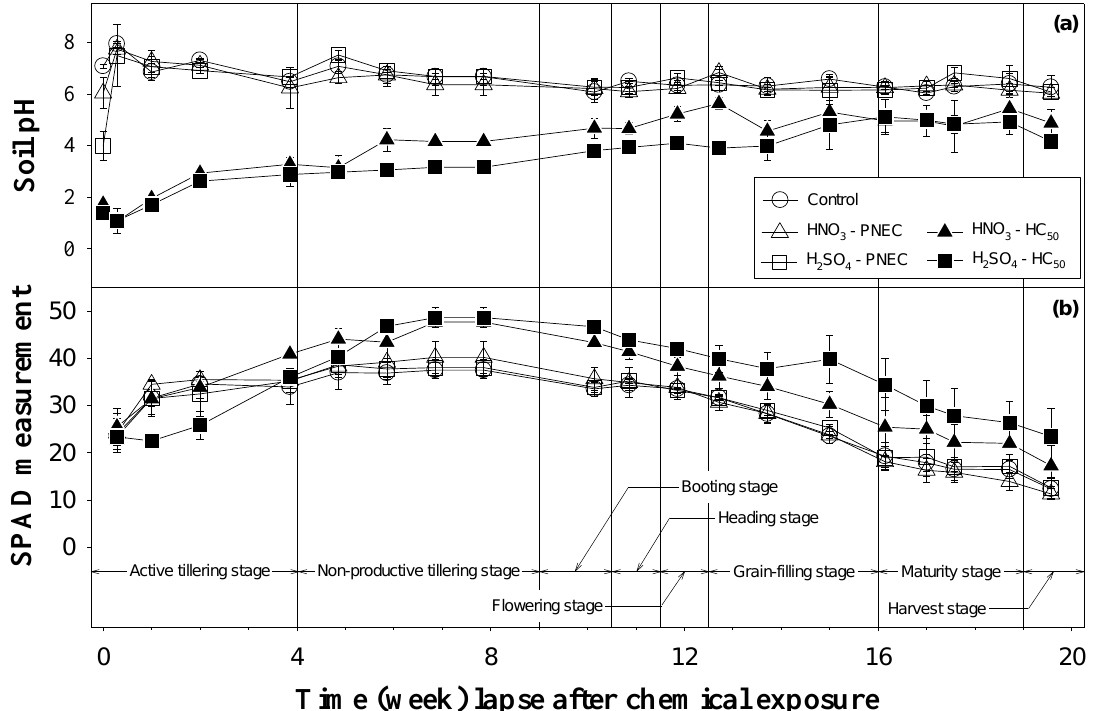
Figure 1. Variations in (a) pH of paddy soils and (b) chlorophyll content of rice ( Oryza sativa ) leaves in the four different treatments (HNO 3 -predicted no-effect concentration (PNEC), HNO 3 -hazardous concentration for 50% of species (HC 50 ), H 2 SO 4 -PNEC, and H 2 SO 4 -HC 50 ) during the 20-week experimental period. Data of the control are also shown for comparison. Growth stage of rice during the experimental is also shown along the x -axis.